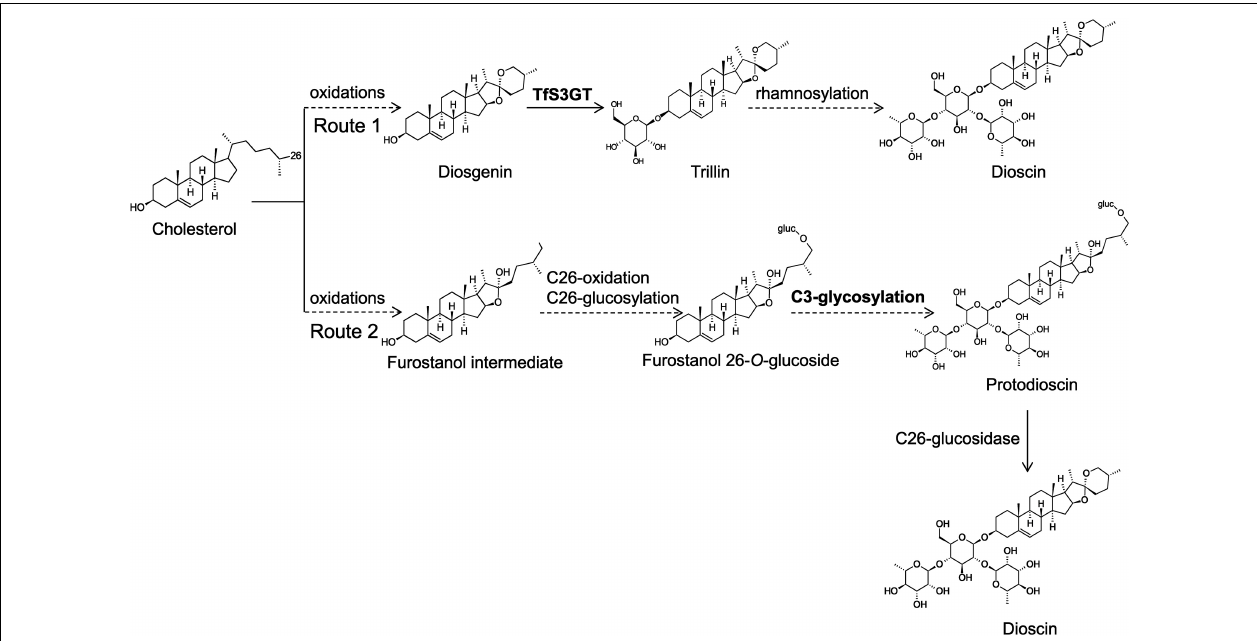
FIGURE 1 | Proposed two glycosylation schemes that may be involved in dioscin biosynthesis in T. foenum-graecum plants. In the route 1, the glycosidic parts (one glucose and two rhamnose moieties) of dioscin are added after the formation of diosgenin skeleton. Diosgenin is biosynthesized from multiple oxidations of cholesterol catalyzed by cytochrome P450s (Christ et al., 2019). In the route 2, the glycosidic parts of dioscin are presumed to be introduced before the formation of diosgenin skeleton, and they may be added at the furostanol level. Cholesterol is converted to proto-dioscin in which the ring F is held open by C26-glucosylation, and from the proto-dioscin intermediate cleavage of the C26-glucose group would evoke closure of the ring F, ultimately producing dioscin.